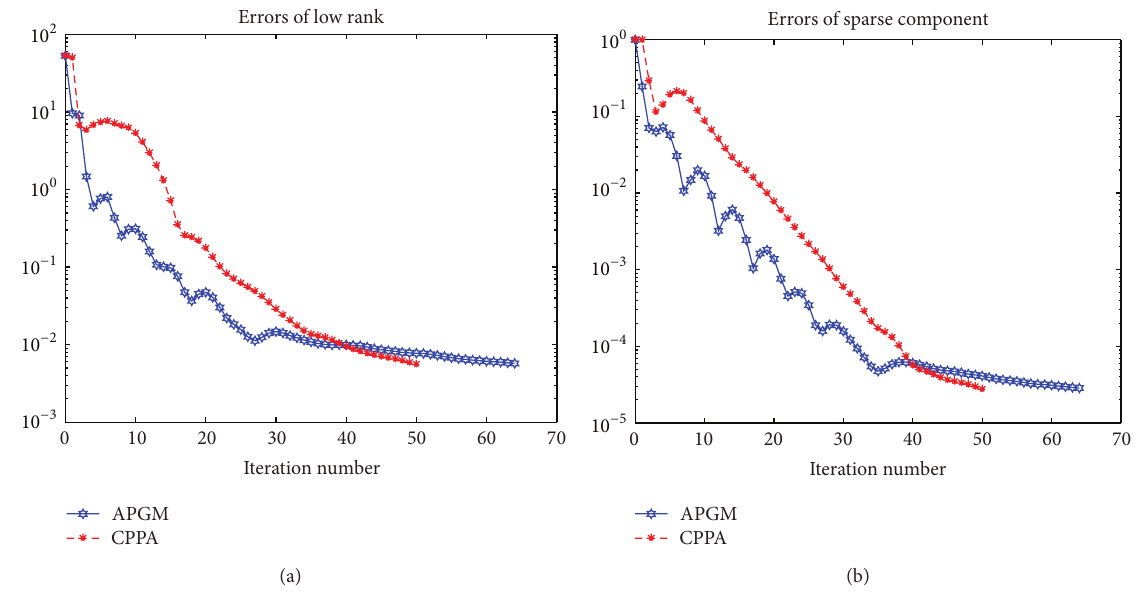
Figure 1: (a) Relative errors of low-rank matrix 𝐿 . (b) Relative errors of sparse matrix 𝑆